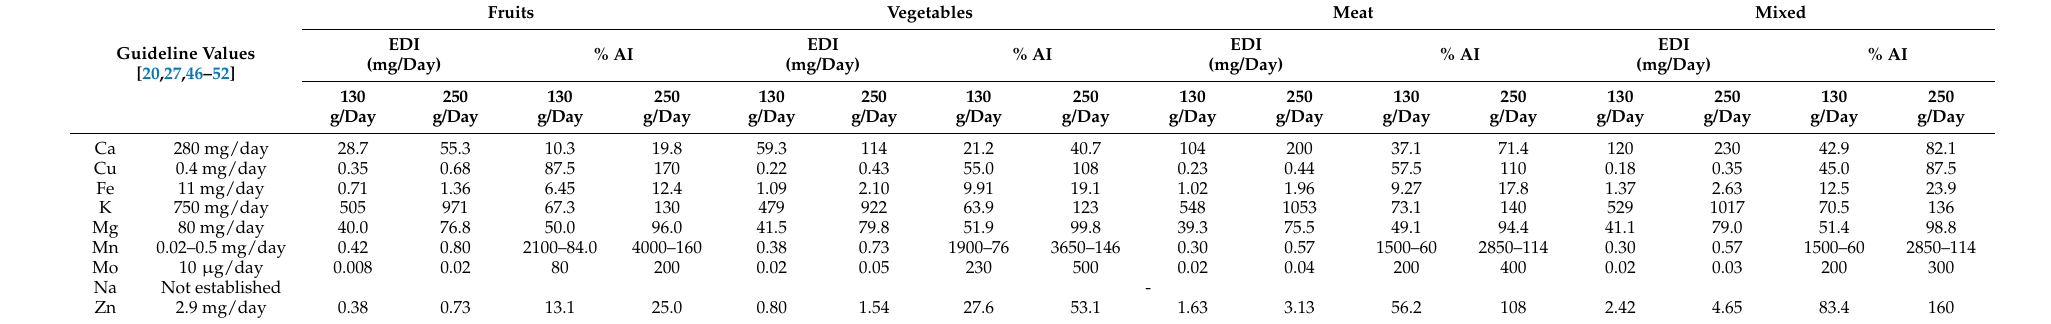
Table 7. Estimated daily intake (mg/day) and percentages of contribution to the AI of the studied essential elements considering a consumption of 130 g/day and 250 g/day of baby food from